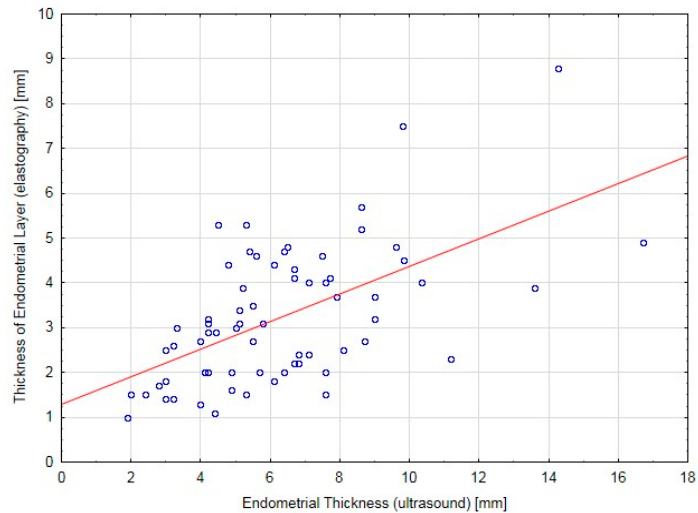
Figure 4. Scatterplot for endometrial thickness (ET) in the ultrasound examination and thickness of the softest endometrial layer in elastography (TEE).